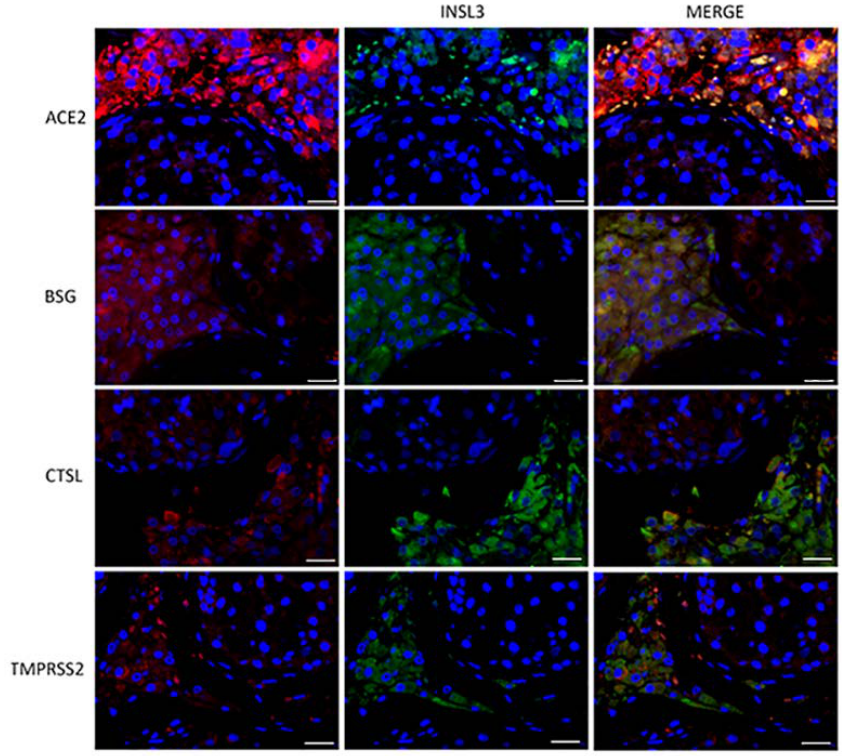
Figure 2. Double-staining immunofluorence of the ACE2 SARS-CoV-2 receptor and the other relevant host factors, BSG, CTLS, and TMPRSS2 (in red), and their colocalization with INSL3, a specific marker of Leydig cells (in green). Scale bar = 25 µm.